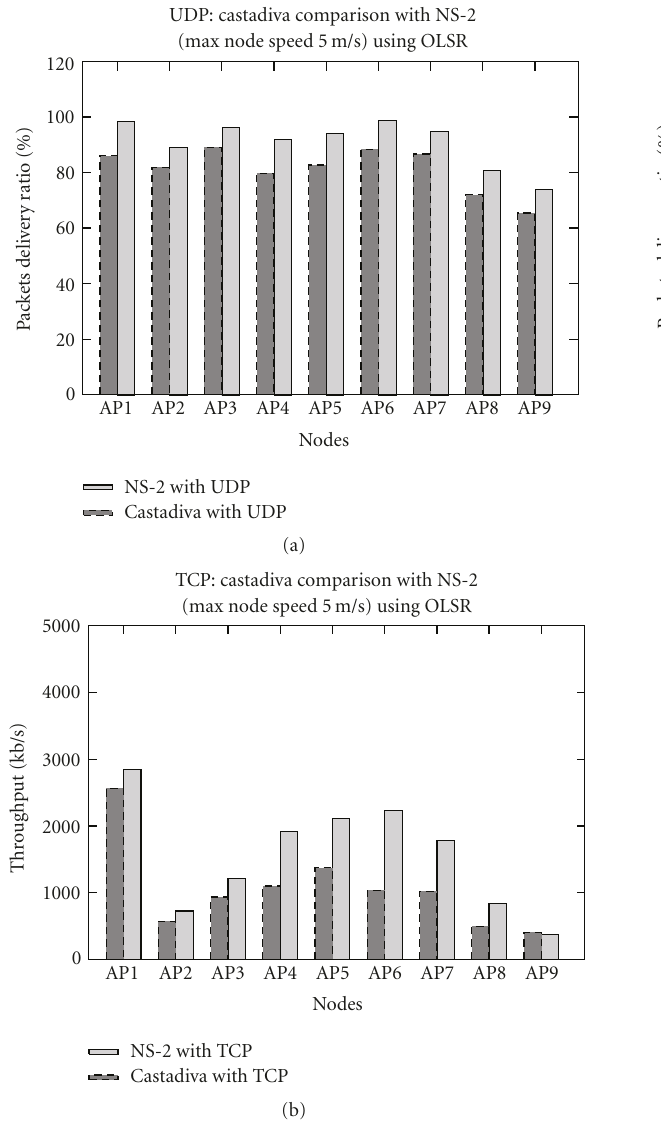
Figure 17: Result comparison of Castadiva with ns-2 for UDP (a) and TCP (b) tra ffi c with routing.